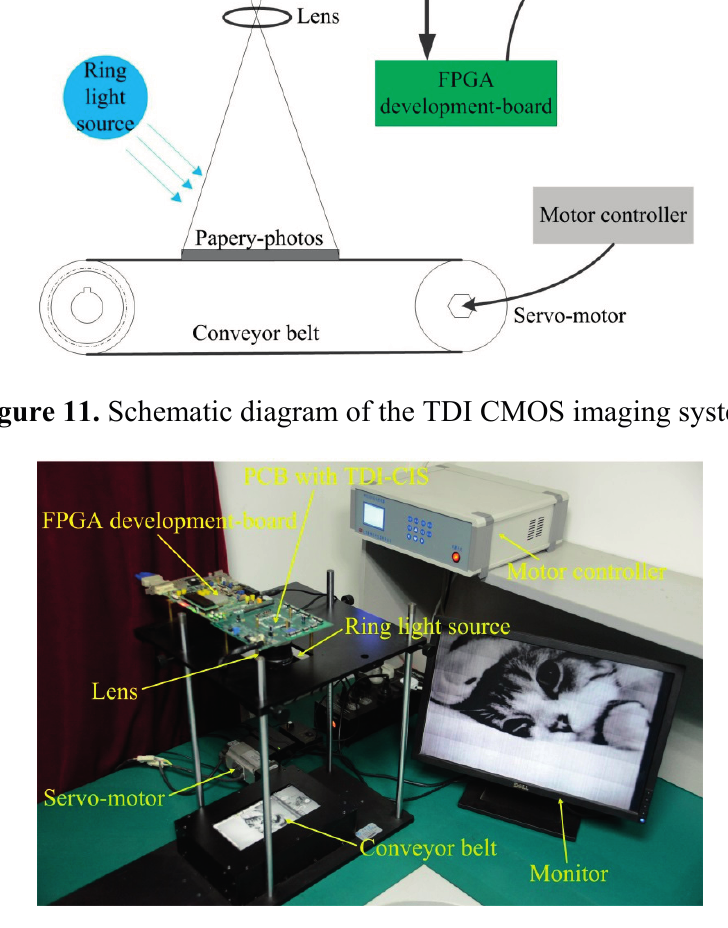
Figure 12. Photograph of the TDI CMOS imaging